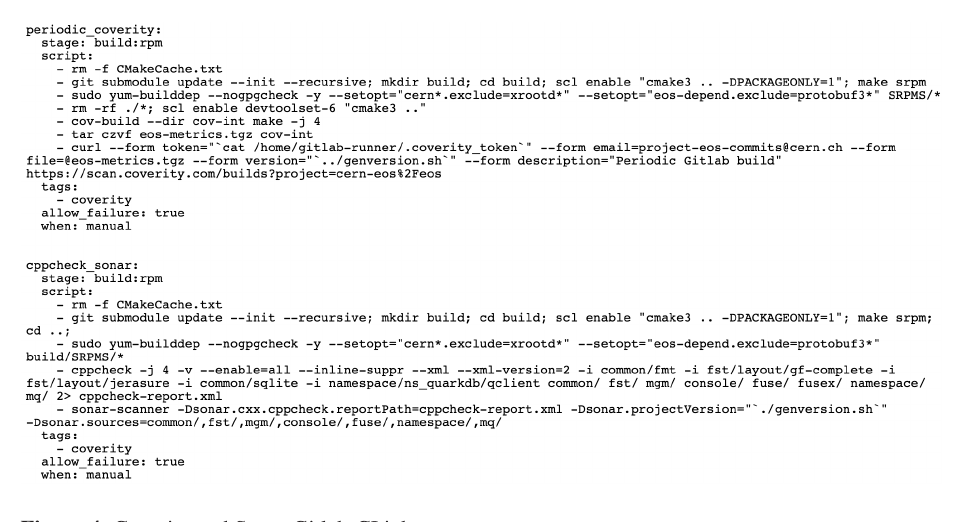
Figure 4. Coverity and Sonar Gitlab-CI jobs